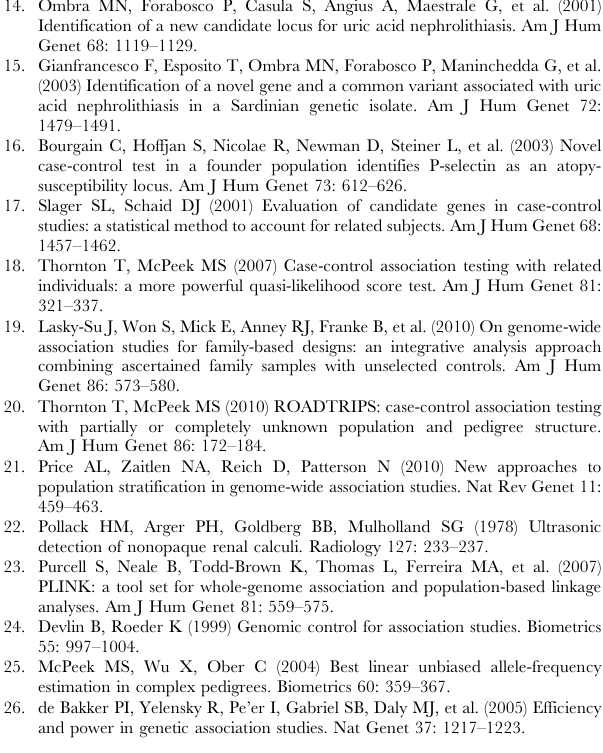
Figure S2 Q-Q plots for R M and R x stratified by warning messages in ROADTRIPS. For the R x statistic warning messages entailing the case, controls or both samples were considered together. Figure S3 pH distribution in Talana (N =218). Red bars indicate pH in affected cases (N =43). The red line indicates the pH level (= 6) in the general population. Table S1 Tagged regions for the replication study and resulting coverage based on r2 . 0.8.